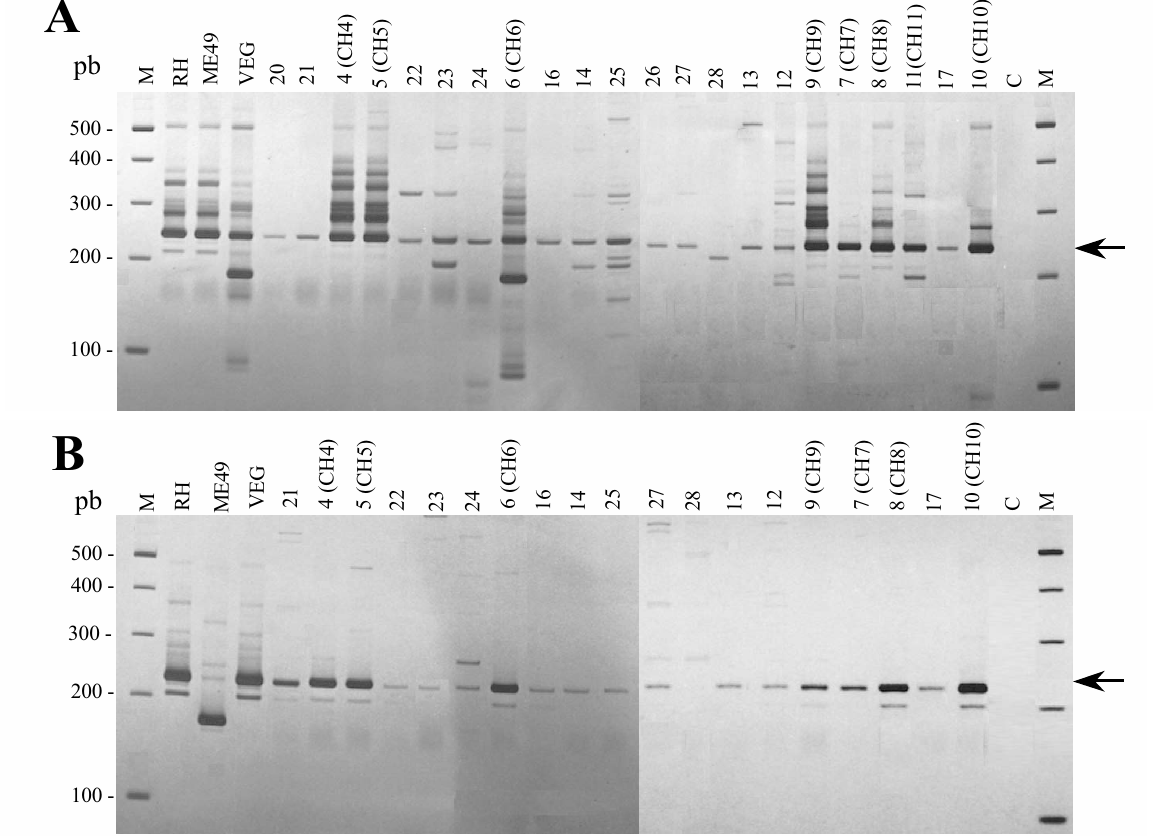
Fig. 1. – RFLP of T. gondii SAG2 locus. (A) region 5’ with the restriction endonuclease Sau3 AI (able to distinguish type III from types I and II); and (B) region 3’ using the restriction endonuclease Hha I (able to distinguish type II from types I and III). Products were resolved in 5 % silver stained polyacrylamide gels for genotyping chicken tissues using the reference strains RH (type I), ME49 (type II) and VEG (type III). M: molecular size marker (Promega 100 pb); C: negative control (no DNA). The arrow indicates restriction